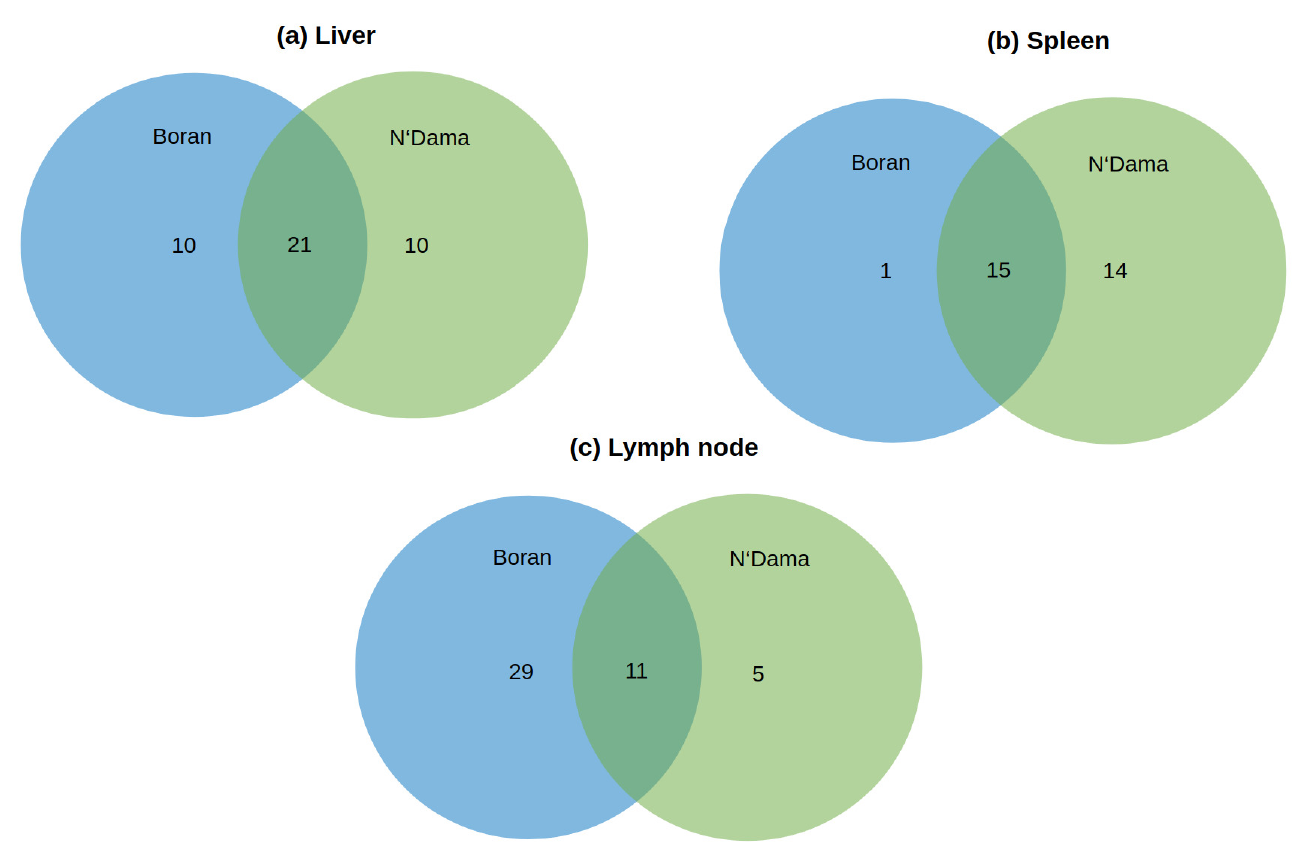
Figure 2. Venn diagram of over-represented pathways ( p -adjusted < 0.05) obtained for liver-, spleen- and lymph node tissues of the two cattle breeds Boran and N’Dama after the infection of Trypanosoma congolense . Pathway enrichment analysis was performed based on the Reactome pathway database